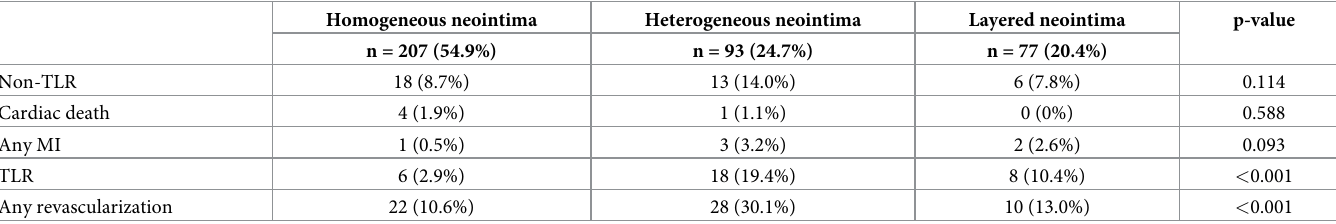
Table 2. Clinical adverse events according to the neointimal characteristics at 40.0 months after OCT evaluation. Homogeneous neointima Heterogeneous neointima Layered